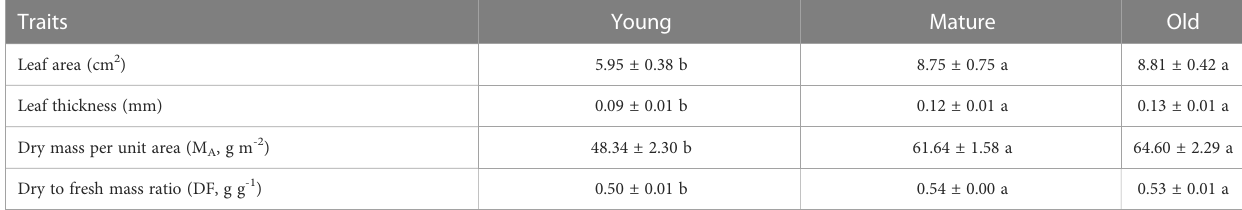
TABLE 1 Mean ( ± SD) values of leaf morphological traits in young, mature, and old culms of Moso bamboo. Traits